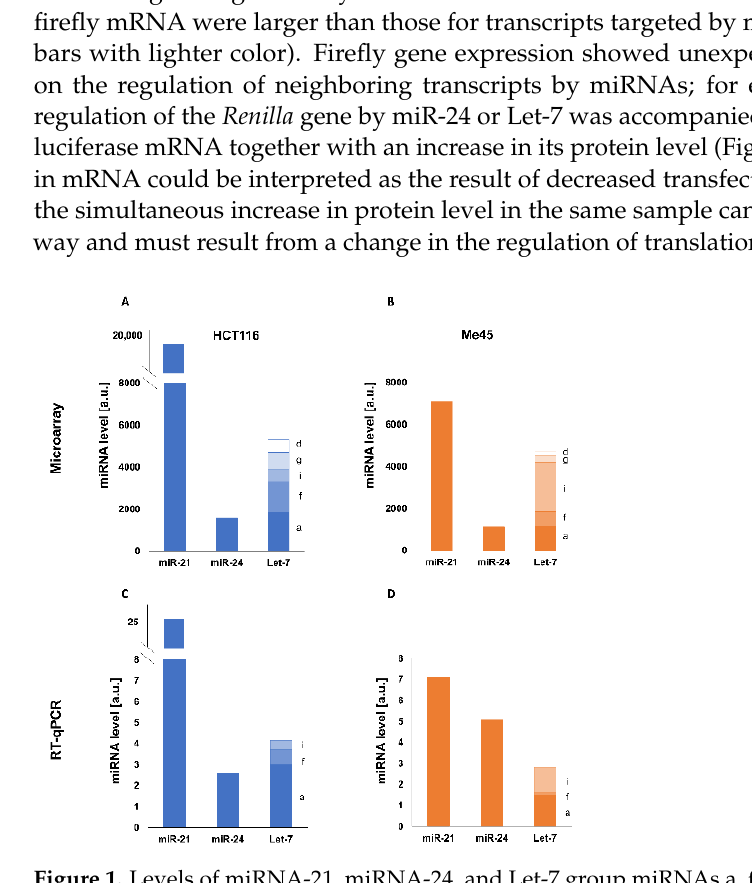
Figure 1. Levels of miRNA ‐ 21, miRNA ‐ 24, and Let ‐ 7 group miRNAs a, f, i, g, and d in HCT116 ( A ) and Me45 ( B ) cells measured by microarrays from E ‐ MTAB ‐ 5197 data from ArrayExpress database and levels of miR ‐ 21, miR ‐ 24, and Let ‐ 7a,f,has in HCT116 ( C ) or Me45 ( D ) cells measured by RT ‐ qPCR.